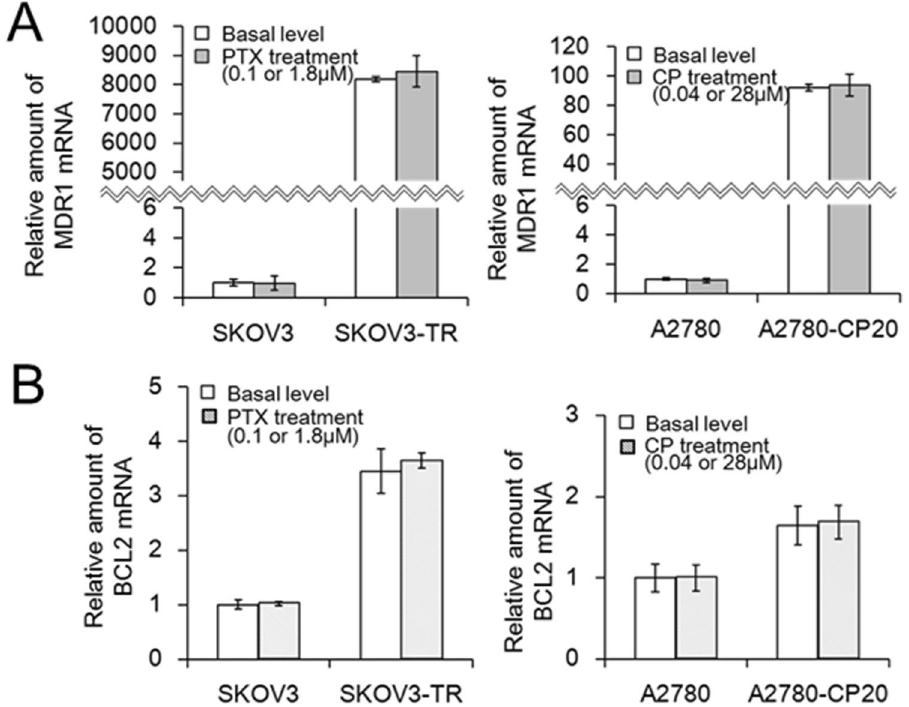
Figure 3. Intrinsic overexpression of MDR1 and BCL2 genes associated with drug-resistance on MDR ovarian cancer cells. The amounts of MDR1 ( A ) and BCL2 mRNA ( B ) on SKOV3 or A2780 parent and resistant cells were measured without or in response to chemotherapeutics treatment. 0.1 μ M and 1.8 μ M of paclitaxel